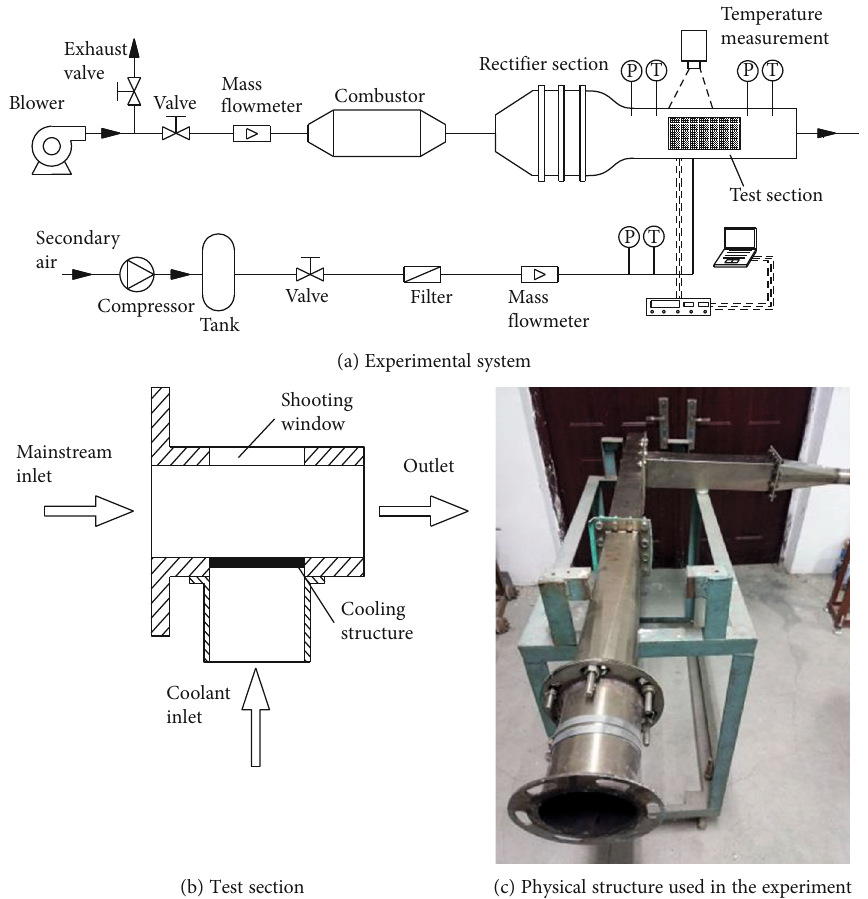
Figure 5: Experimental system in the present